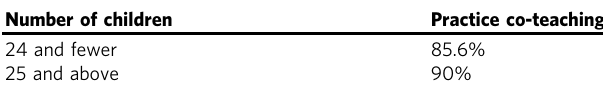
Table 5 Co-teaching situation by classroom size ( n = 210).